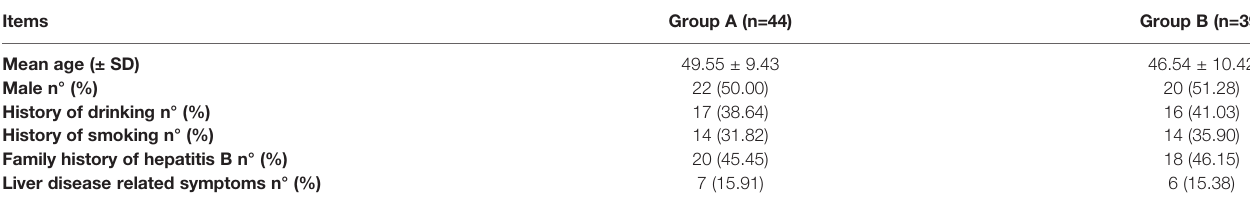
TABLE 1 | Baseline characteristics of OBI patients at week 0.